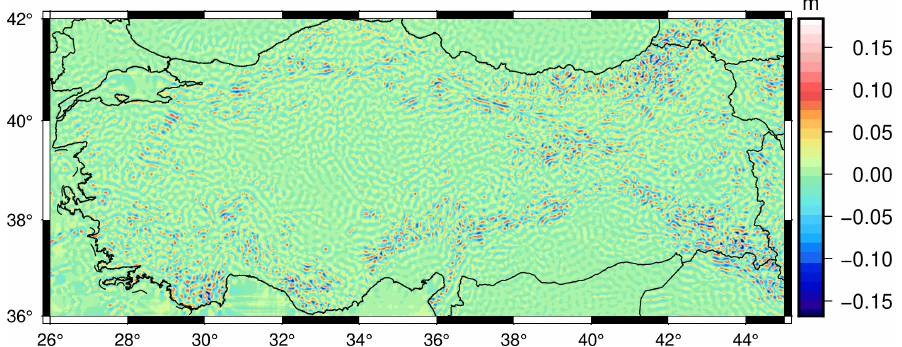
Figure 1. Residual terrain effects on geoid from ERTM2160 model ( Minimum = − 0.168 m, Maximum = 0.184 m, Mean = 0.000 m, SD = 0.025 m).